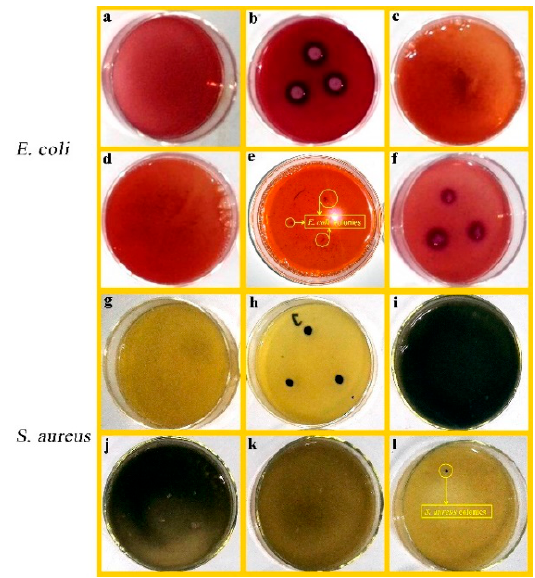
Figure 7. ( a ) Blank control, ( b ) positive control of E. coli , E. coli treated with ZnO/PAL nanoparticles at various concentrations of ( c ) 2.5 mg/mL, ( d ) 1.5 mg/mL, ( e ) 1 mg/mL, and ( f ) 0.5 mg/mL, ( g ) blank control, ( h ) positive control of S. aureus , S. aureus treated with ZnO/PAL nanoparticles at various concentrations of ( i ) 10 mg/mL, ( j ) 5 mg/mL, ( k ) 2.5 mg/mL, and ( l ) 1.5 mg/mL.